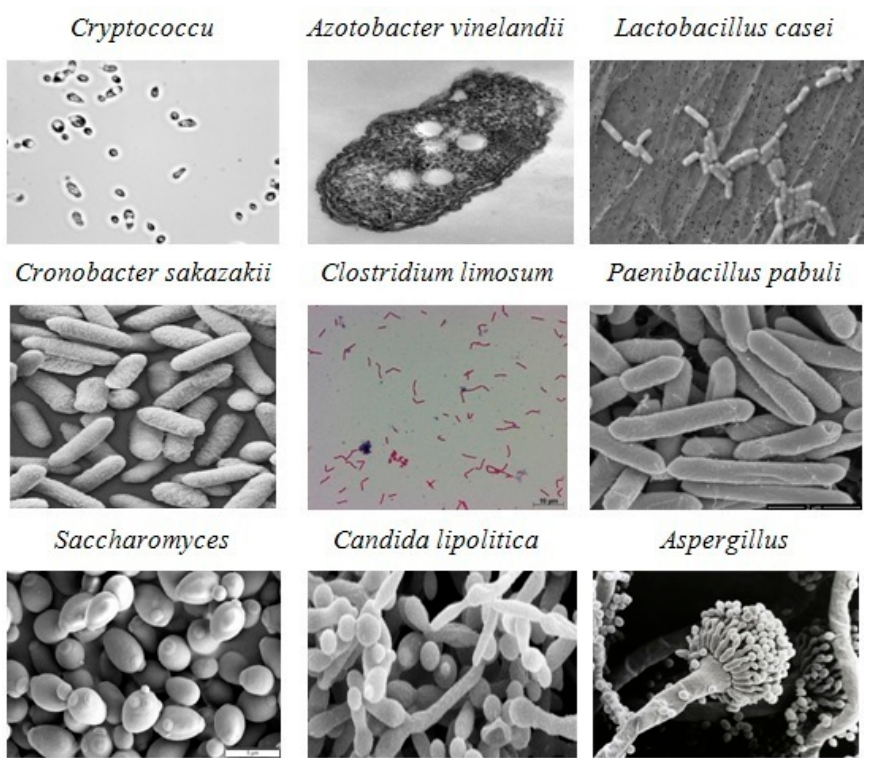
Figure 3. The variety of bacteria, yeast, and fungi in “Baikal EM-1”.